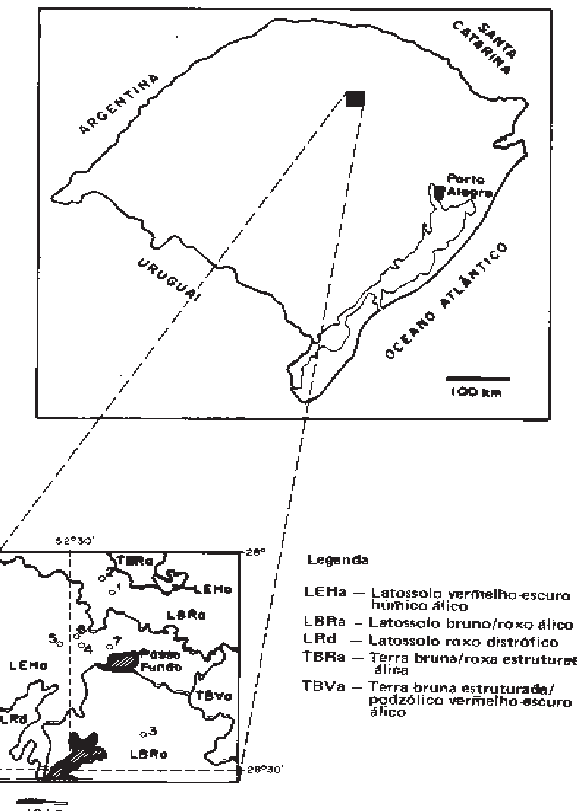
Figura 1. Localização da área de estudo no Estado do Rio Grande do Sul, Brasil, e das glebas amostradas e sua distribuição de solos (Brasil/ IBGE-EMBRAPA, 1986).